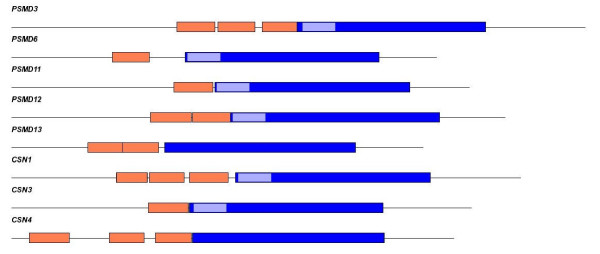
TPR-like motifs upstream and inside the PCI domain. The proposed domain topologies of selected human PCI proteins were investigated by profile techniques. Besides the common PCI domain (blue) short stretches of ~35 aa each are depicted in orange and light blue. These stretches show weak to medium similarity to TPR segments in established TPR proteins and merge seamlessly into the PCI domain in several PCI subunits. Corresponding accession numbers are listed in figure 2.